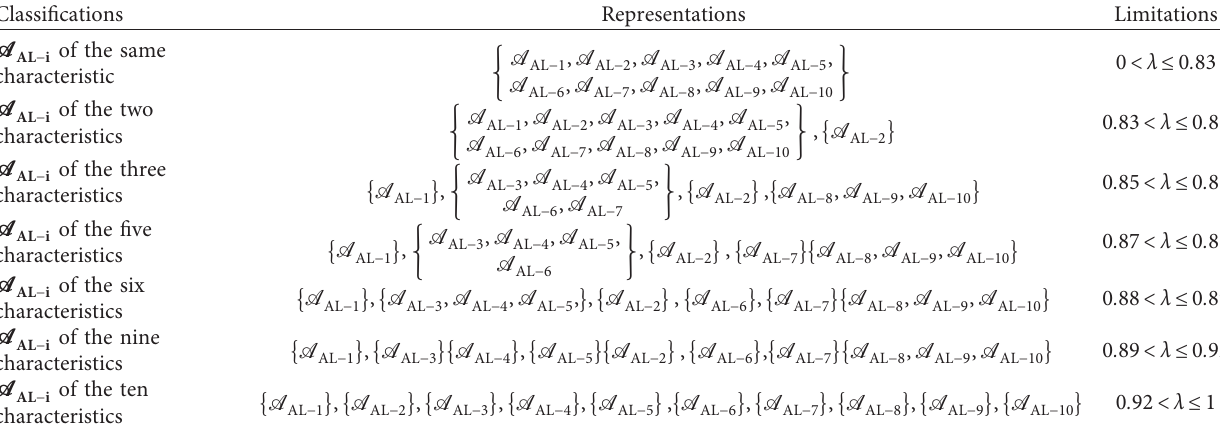
Table 5: All possible classifications based on λ -cutting